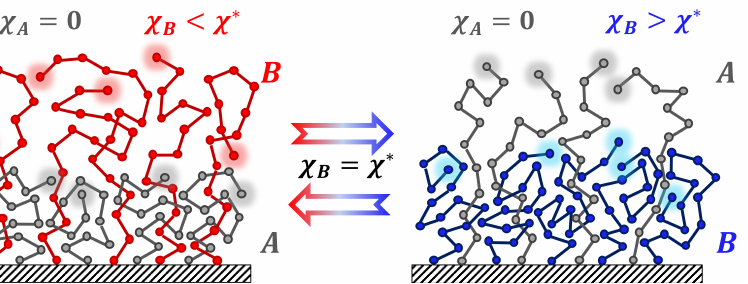
Figure 1. Schematic representation of vertical phase segregation in a binary polymer brush consisting of two components, A and B ( σ A = σ B , N A < N B